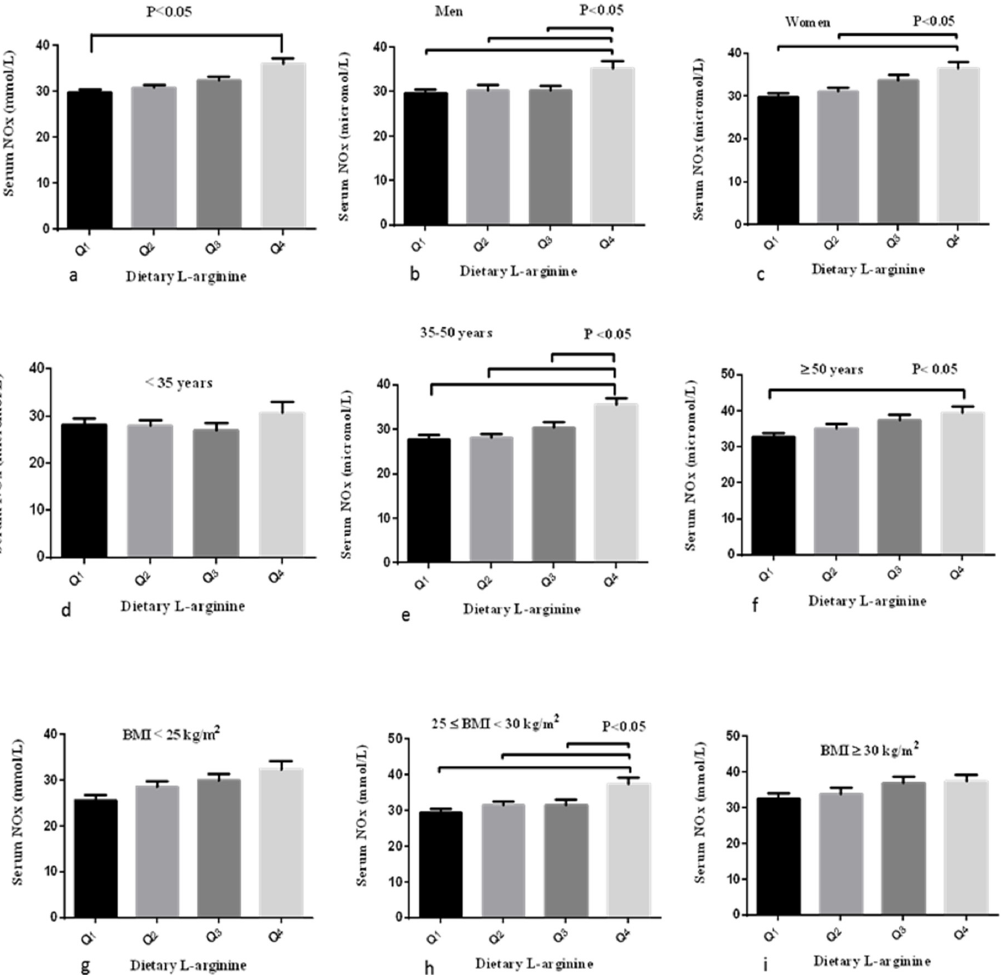
Figure 1. Mean serum NOx across quartile categories of L ‐ arginine intakes stratified by sex, age